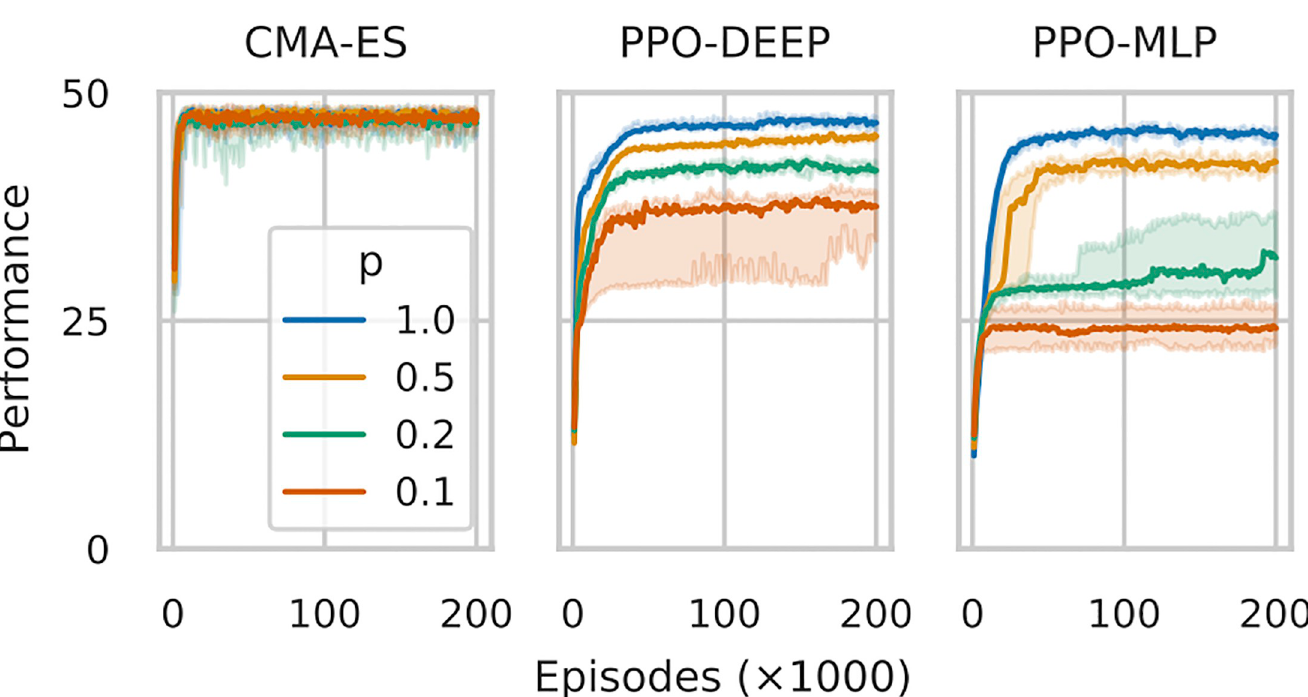
Fig 3. Performance of the best policies (median and 95% confidence interval) throughout learning with CMAES, PPO-DEEP and PPO-MLP for the 3 conditions with rare significant events ( p 2 {0.1, 0.2, 0.5}) and 1 control condition ( p = 1.0, same data as shown in Fig 1), for the first 75 � 10 3 episodes (out of 200 � 10 3 ).